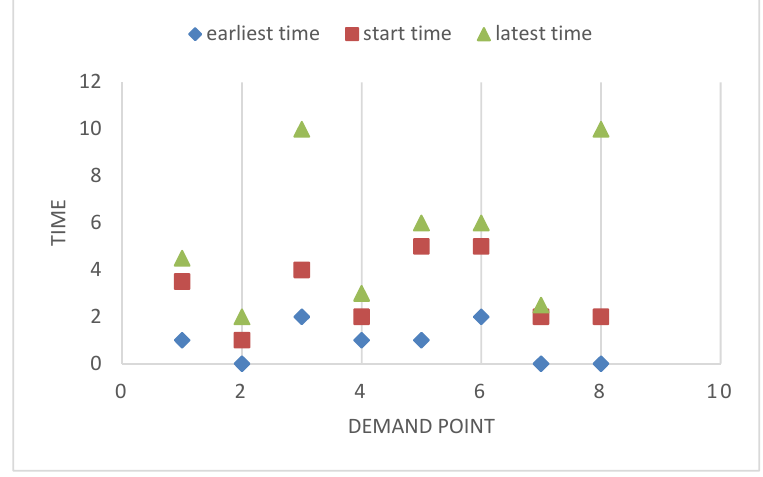
Figure 5. Compliance check for soft time windows.